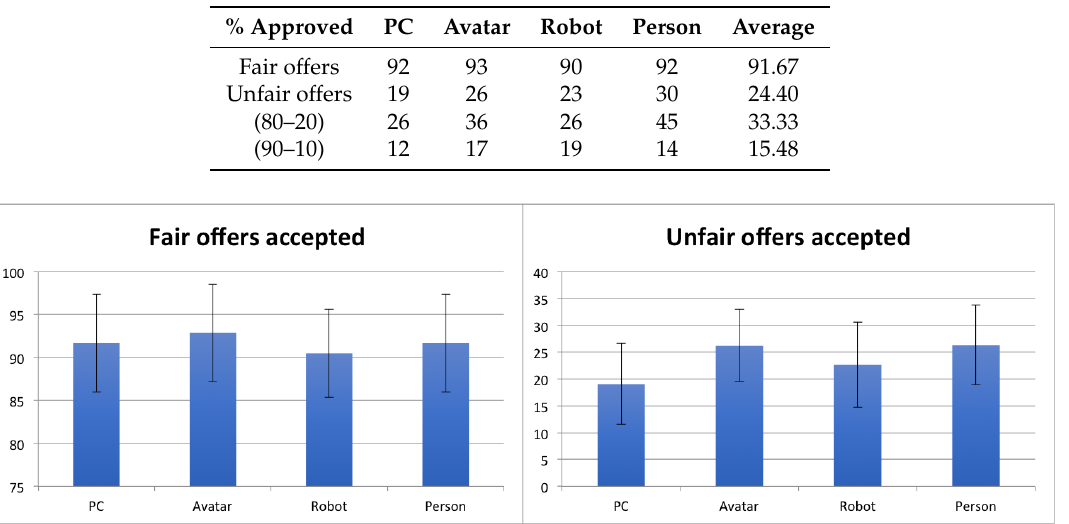
Figure 4. Average number of fair ( left ) and unfair ( right ) offers accepted per condition, with confidence